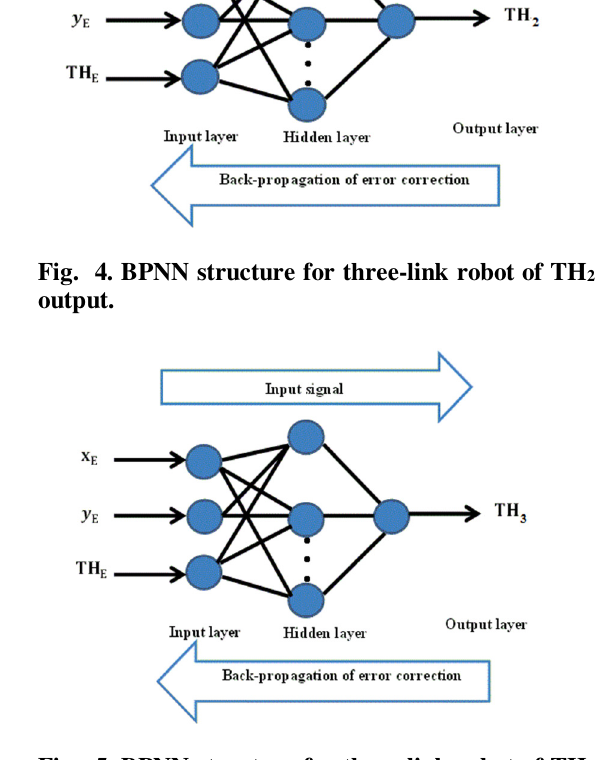
Fig. 5. BPNN structure for three-link robot of TH 3